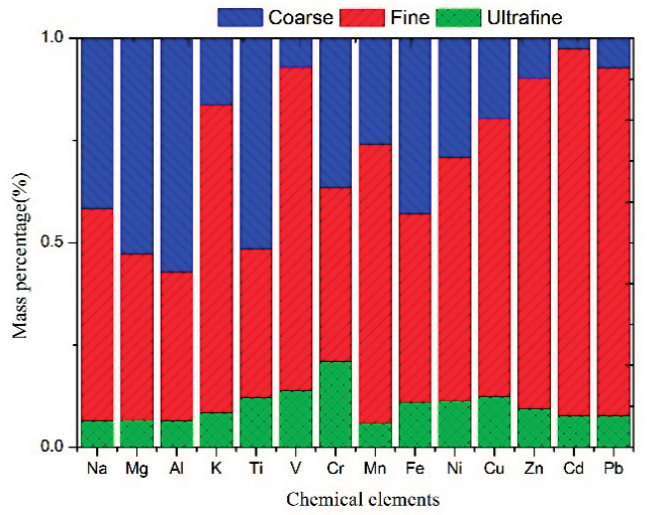
Figure 3. The mass ratios of the metallic elements in the coarse particles (blue), fine particles (red) and ultrafine particles